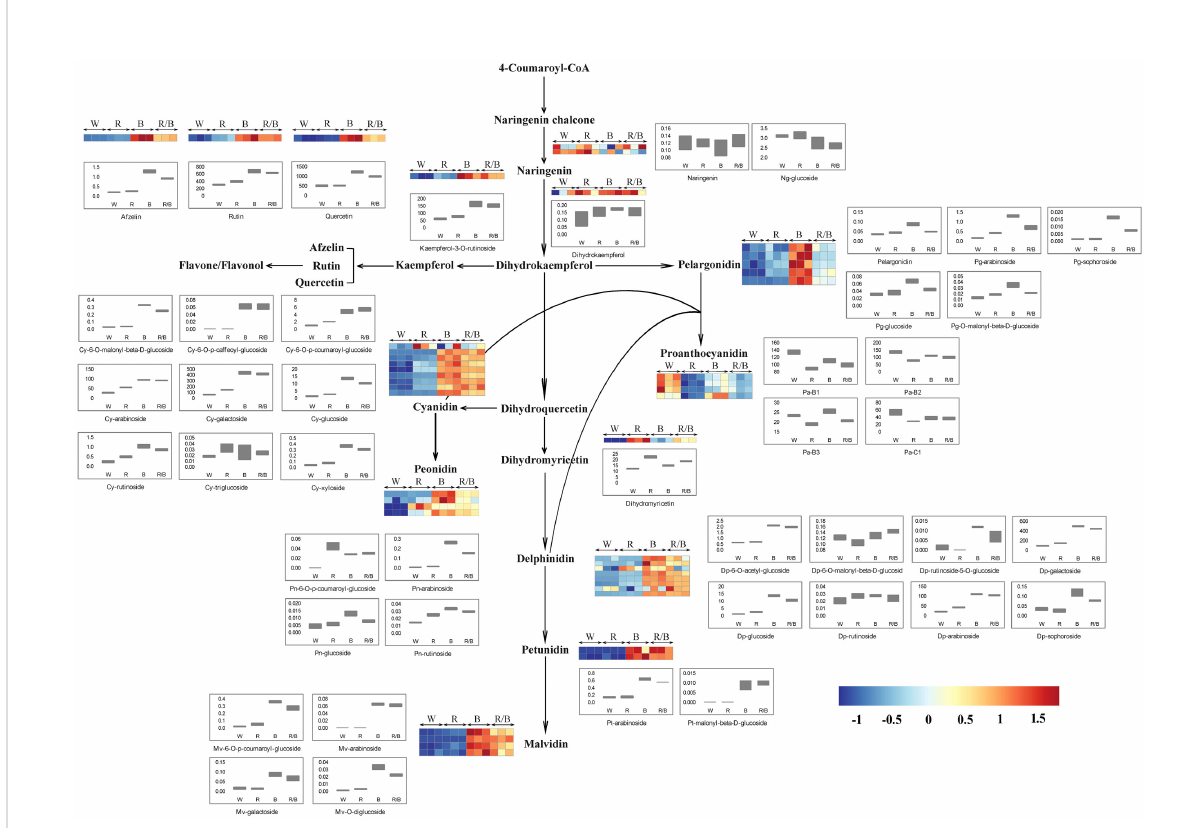
FIGURE 7 Model showing the changes in the abundance of anthocyanin and fl avonoid biosynthesis pathway metabolites in blueberry leaves under different light qualities. The model was constructed based on the KEGG pathway and a literary reference. Ng, naringenin; Pg, pelargonidin; Cy, cyanidin; Pa, proanthocyanidin; Pn, peonidin; Dp, delphinidin; Pt, petunidin; Mv, malvidin; W, white; R, red; B, blue; R/B, Red/Blue; Each colored unit represents the normalized intensity of each compound ion according to the color scale (three biological replicates × four treatments, n =12). Box-and-whisker plots show the changes in the metabolites for each treatment. Maximum and minimum values of a metabolite among three biological replicates are represented at the upper and lower ends of the whisker,